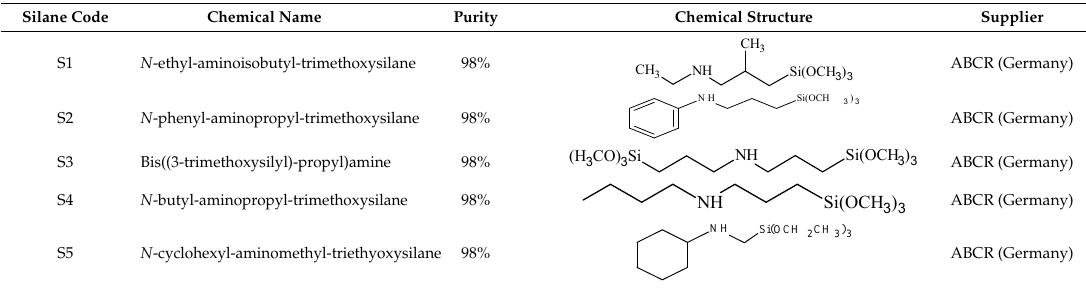
Table 1. General information of secondary aminoalkoxysilanes.